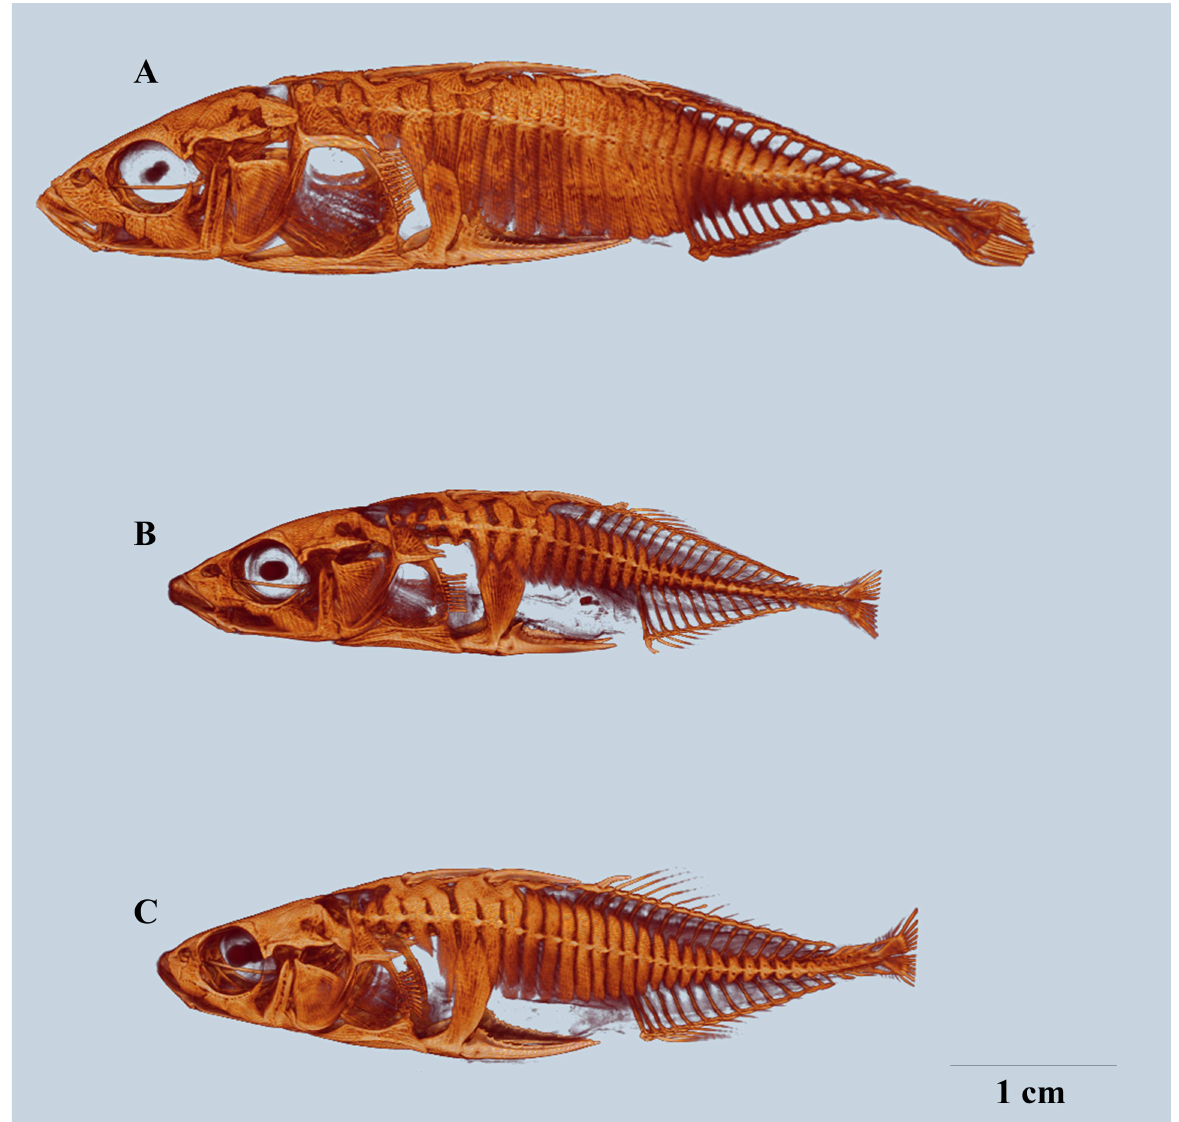
Fig 3. The Barents Sea fish (A) display a complete and rigid armour; lateral plates are covering the majority of the fish body and abutting. Completeplate morph from Asd ø ltjern(B), displayingreduction in size of lateral plates. Complete plate morph from Gardatj ø rna(C), displayingreduction in size of lateral plates to lesser extent. Representative images for the populations. Scale bar 1